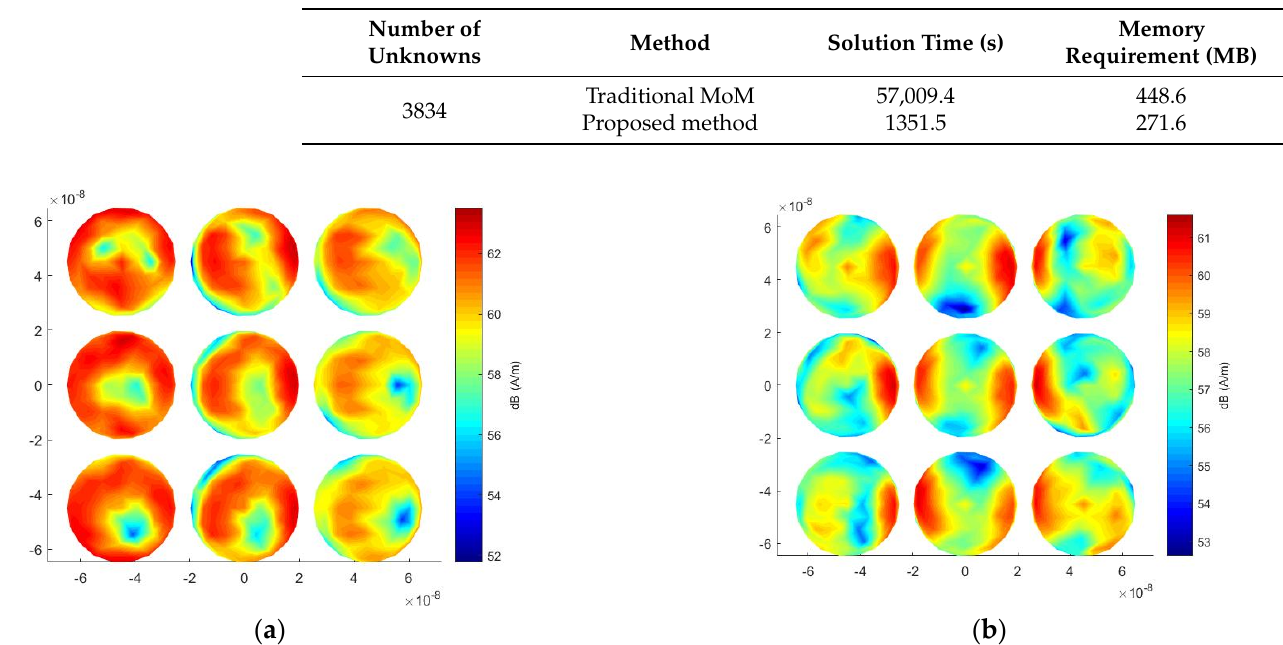
Figure 7. Surface current distribution under different incident angles at 350 nm wavelength for the nanosphere array. ( a ) 120° incident angle; ( b ) 180° incident angle.